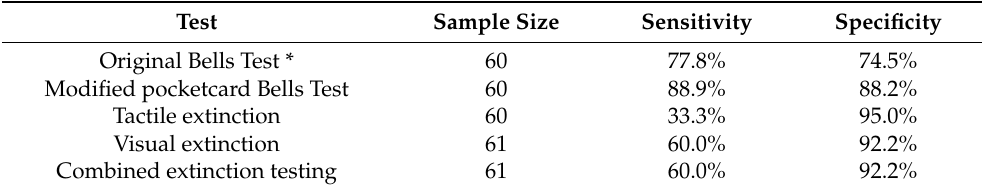
Table 1. Neglect testing procedures compared with overall clinical judgement by the treating stroke unit team. Test Sample Size Sensitivity